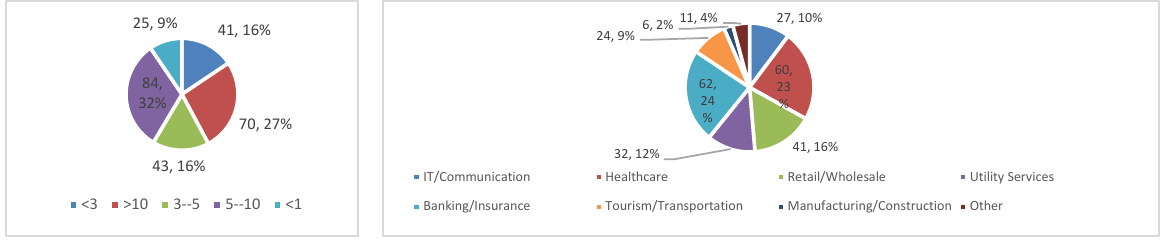
Fig. 3. Demographic information- Length of service and Industry